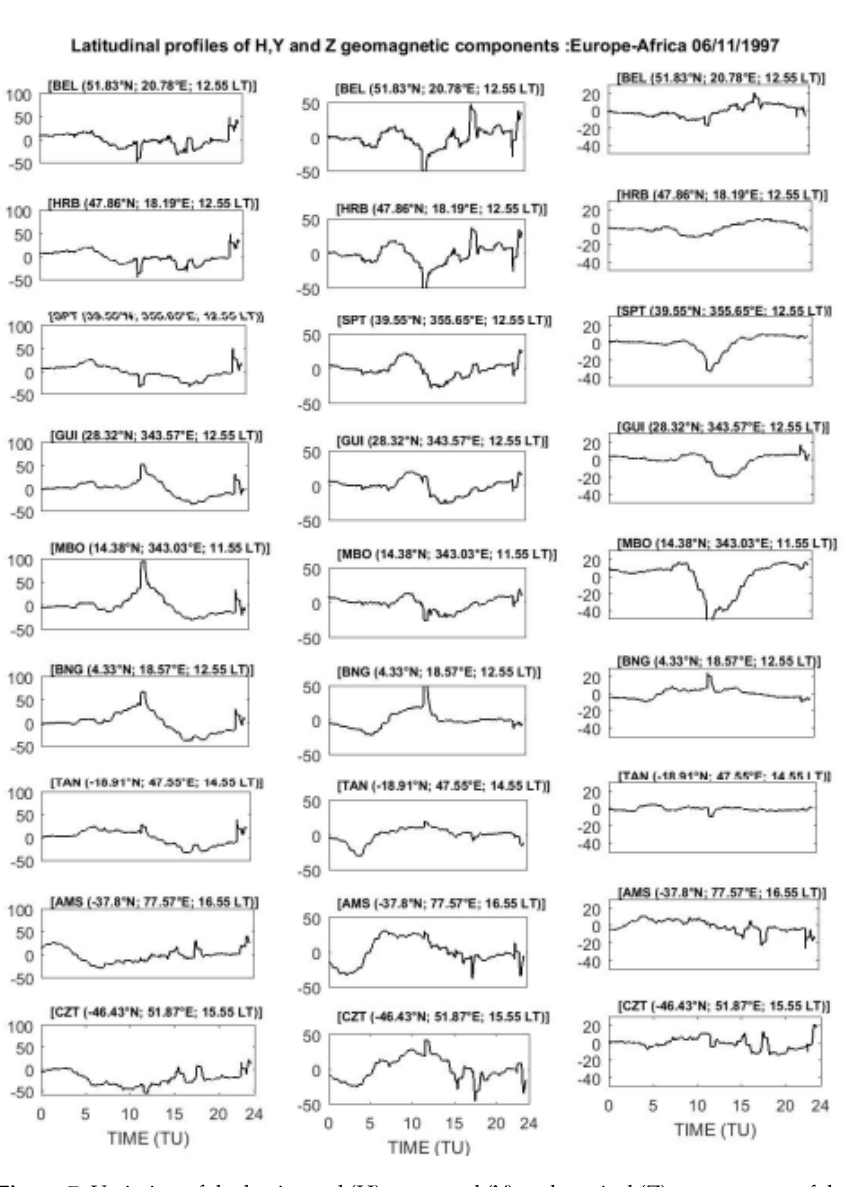
Figure 7. Variation of the horizontal (H), eastward (Y) and vertical (Z) components of the geomagnetic field during the X9.4 solar flare on 6 November 1997. The eastward component (Y) also exhibited the negative magnetic crochet at all sta- tions except in CZT. The magnitudes of the crochet on the Y component were generally strong near the magnetic equator. The sfe maximum value was observed in BNG with ΔY sfe = −46.73 nT at 11:58 LT. Furthermore, the vertical component (Z) showed the nega-